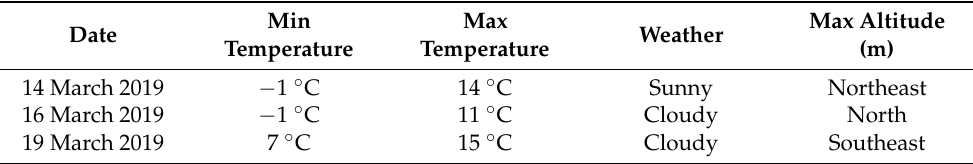
Figure 3. The flight trajectory on 16 March 2019 over Qinhuangdao, China. The color bar represents the progression of time, where blue represents the starting time and red represents the ending time. Table 2. The weather report was released by the Meteorological Station of Qinhuangdao City on 14, 16, and 19 March